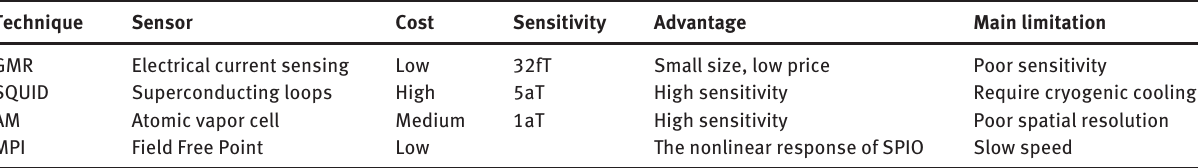
Table 1 List of ultra-low field techniques for molecular and cellular magnetic imaging and analysis.